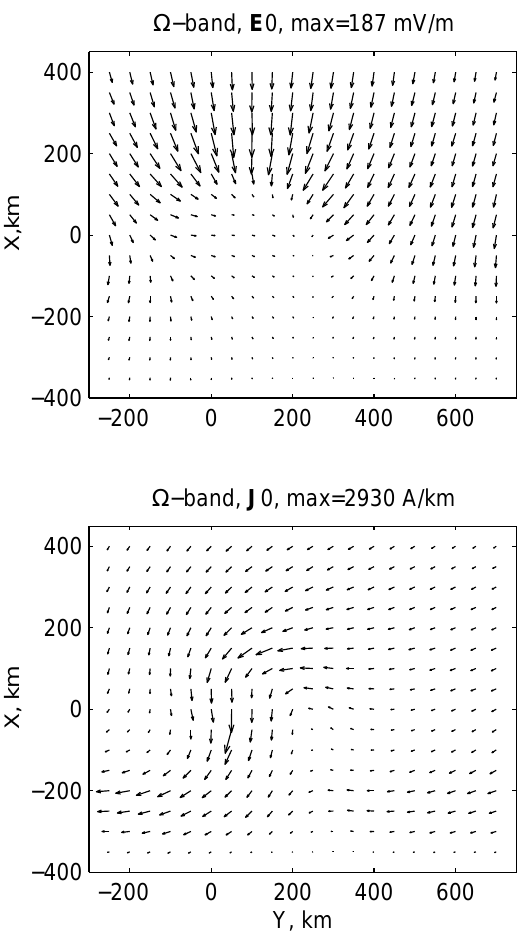
Fig. 3. The driving electric field and associated currents of the (cid:127) - band model.